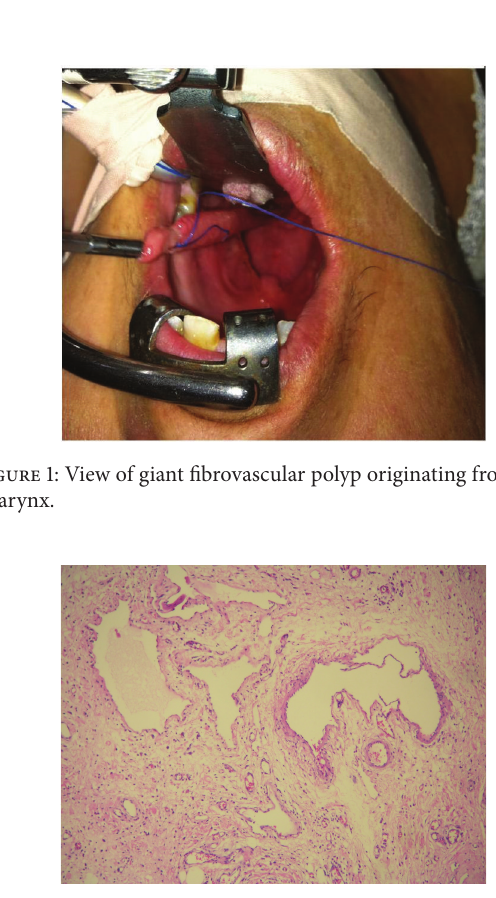
Figure 2: Microscopic view showed an oedematous subepithelial fibrous stroma, surrounded by squamous epithelium and containing many congested vascular structures (100x,